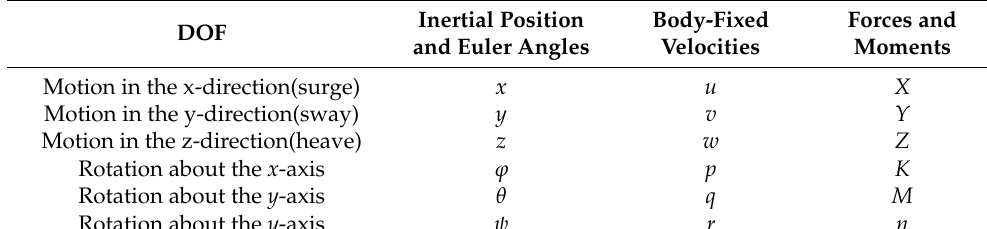
Table 2. Six DOF motion components of the manta ray robot.